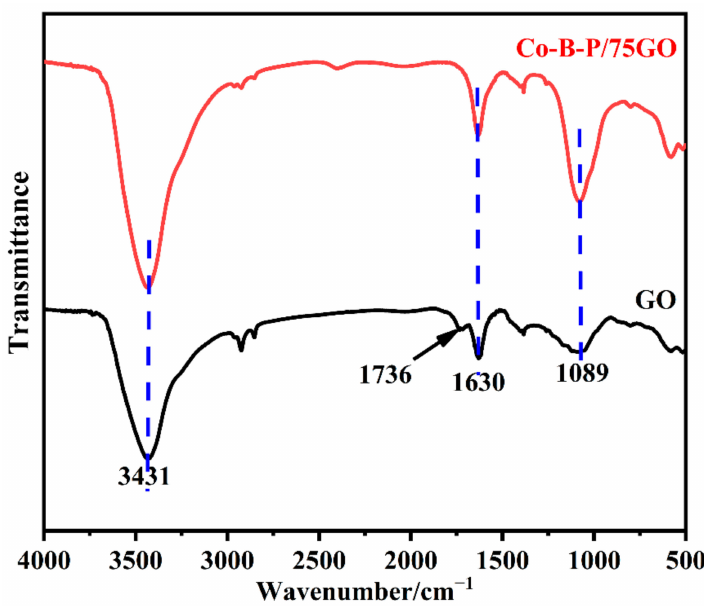
Figure 4. FTIR spectra of GO and